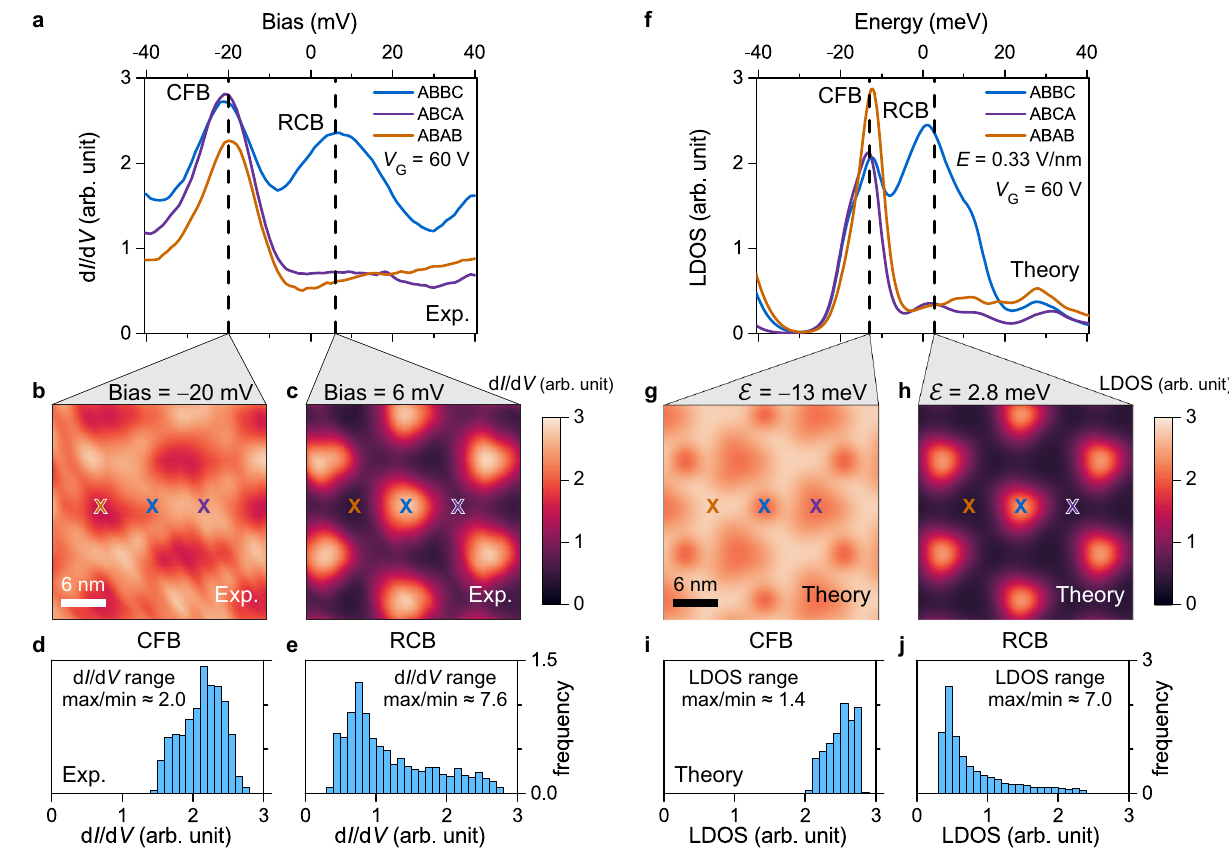
Fig. 3 Spatial distribution of conduction fl at band and remote conduction band wavefunctions. a d I /d V spectra for three different stacking regions measured at V G = 60 V. b , c d I /d V maps of the same tDBLG region obtained at b V Bias = – 20 mV and c V Bias = 6 mV (modulation voltage V RMS = 1 mV; initial V Bias = – 500 mV, I 0 = 2.5 nA). d Histogram of b . e Histogram of c . f Theoretical LDOS of three different stacking regions for V G = 60 V and E = 0.33 V/nm using a single-particle continuum model. g , h LDOS maps at energies ( g ) – 13 meV and ( h ) 2.8 meV. i Histogram of g . j Histogram of h . All histograms use bin size of 0.1 arb. unit. Areas under histograms are normalized to 1. CFB conduction fl at band, RCB remote conduction